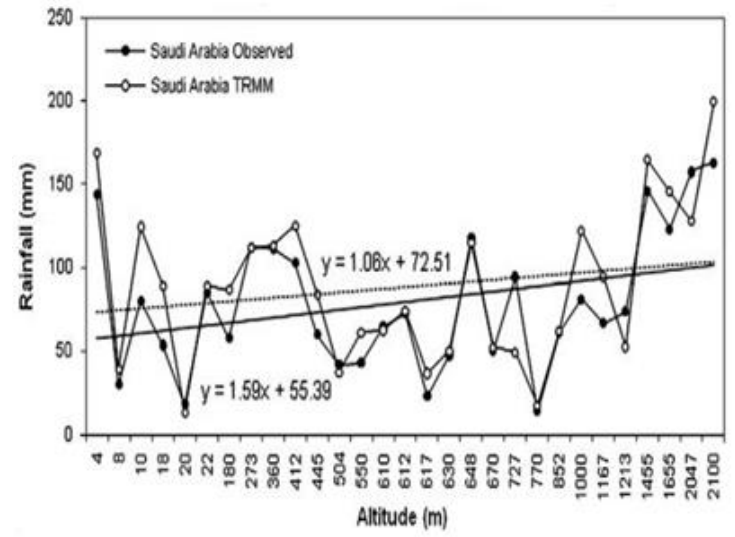
Figure 15. The variation of rainfall (mm) with altitude in Saudi Arabia. The rainfall values are averaged over 1998–2009